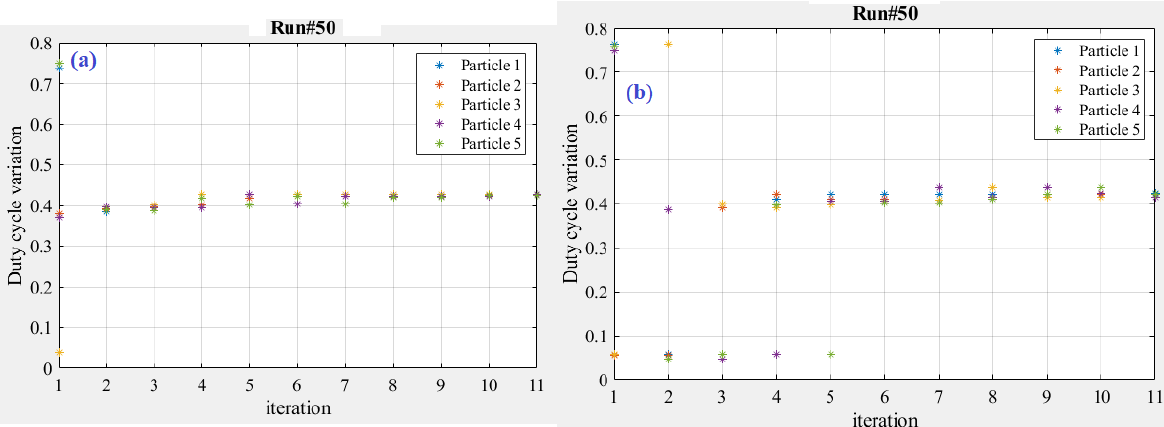
Figure 7. Decision variable (duty cycle) variation during optimization process of SFS based tracker ( a ) forth shading scenario ( b ) fifth shading scenario.